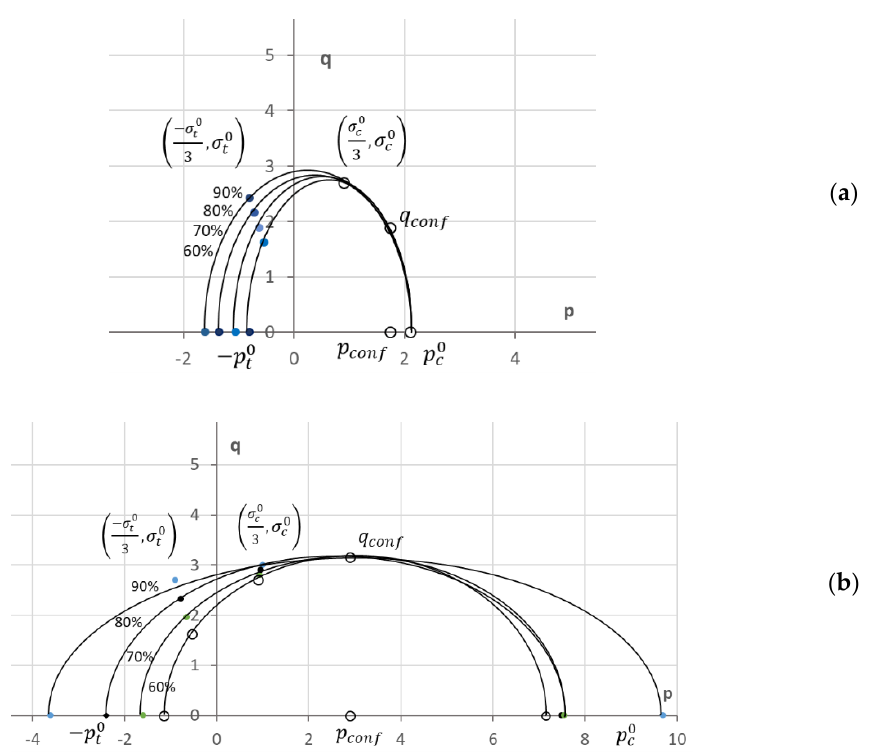
Figure 10. Possible ellipses of CFV constitutive model for trabecular bone with ( a ) 3 MPa and ( b ) 5 MPa.